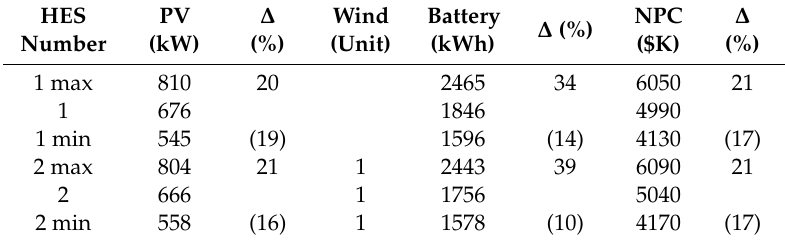
Table 8. Sensitivity analysis of climate loading extremes, including percent di ff erence ( ∆ ) from optimal